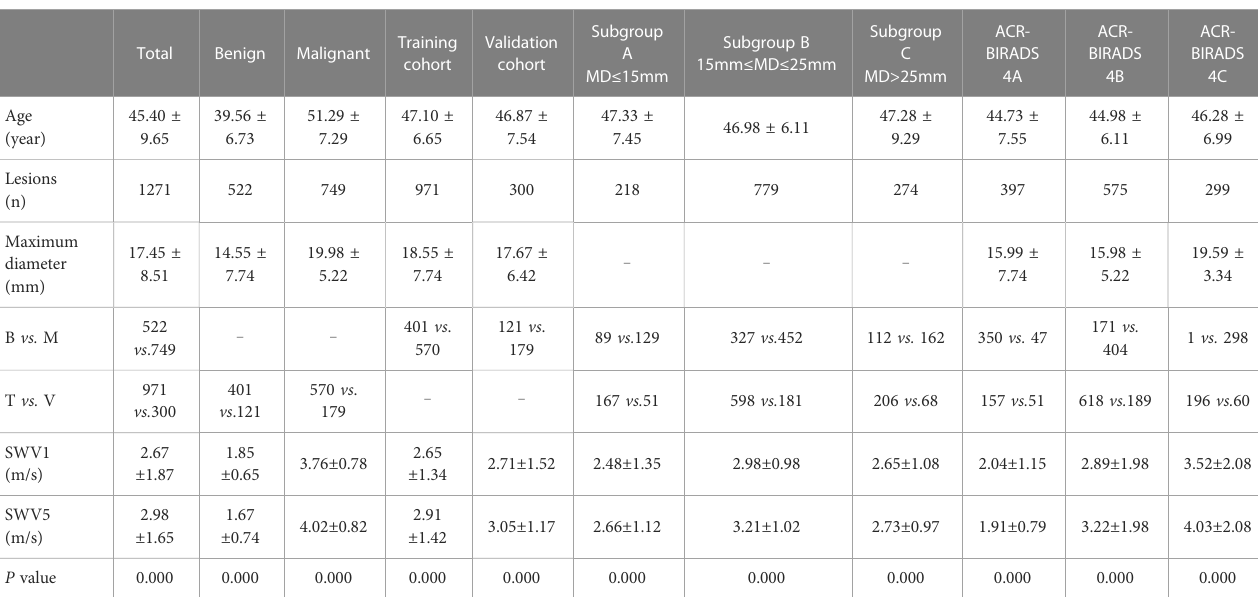
TABLE 1 Distribution of subgroups studied and quantitative SWE parameters of all lesions.